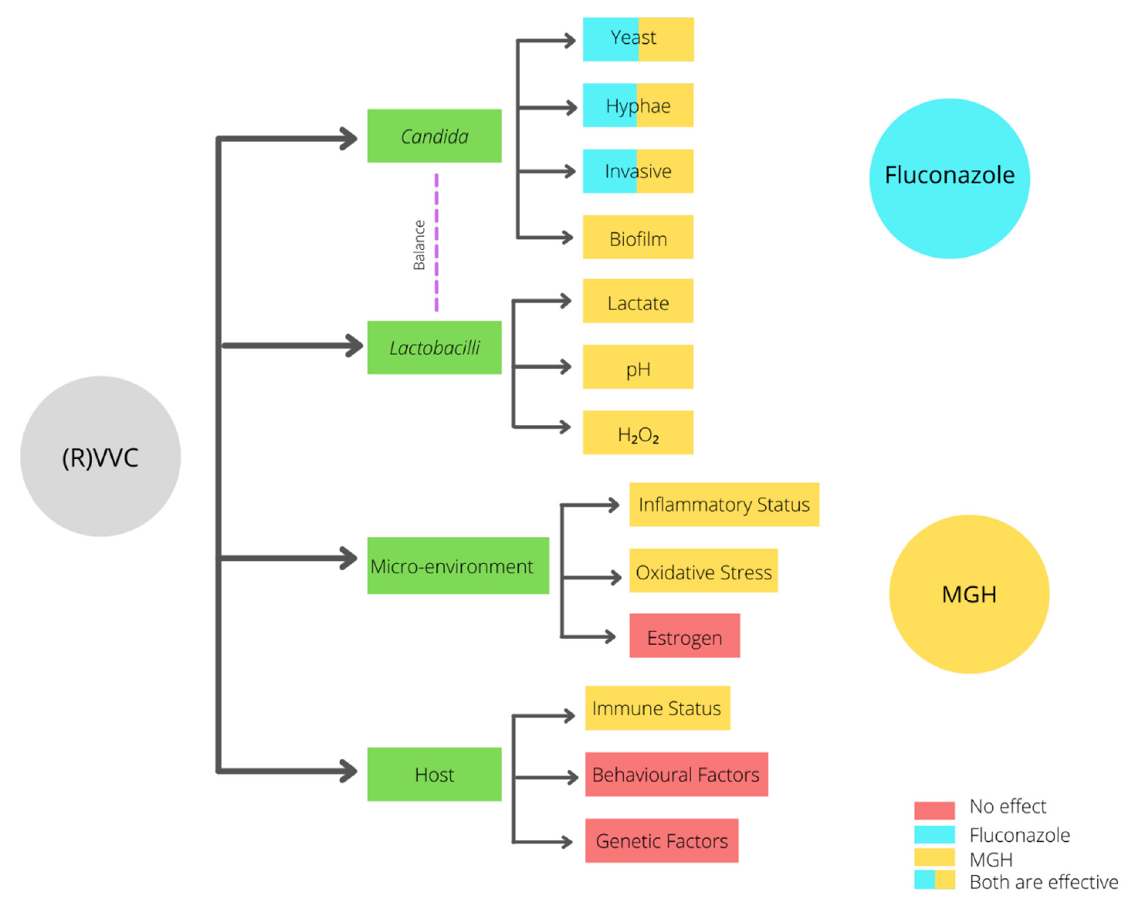
Figure 2. Differential antipathogenic activity of fluconazole and MGH on the pathogenesis of RVVC.